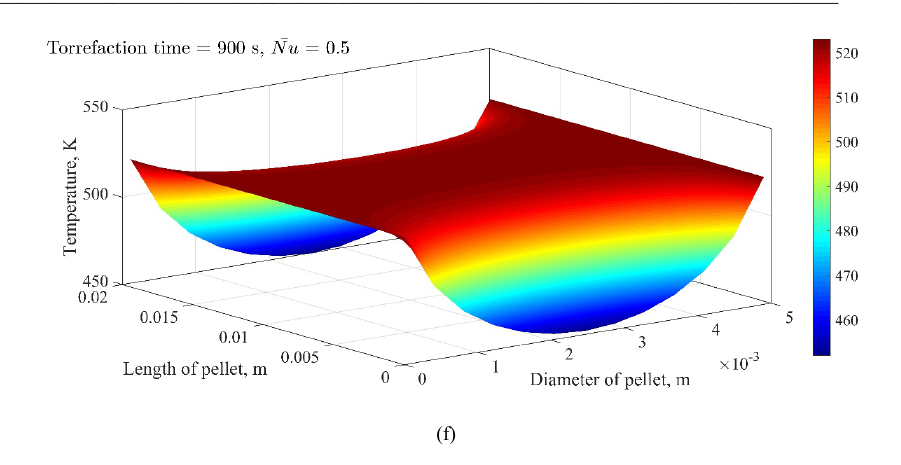
Fig. 7. The effect of Nusselt number on the temperature distribution: a–b) 81.55 kW·m − 2 ; c–d) 84.88 kW·m − 2 ; e–f) 86.068 kW·m − 2